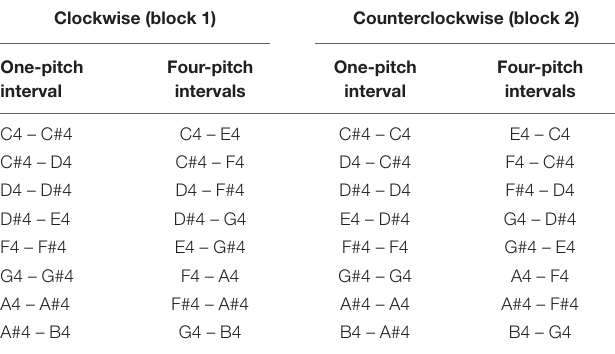
TABLE 2 | Two blocks of tone pairs with one-pitch and four-pitch